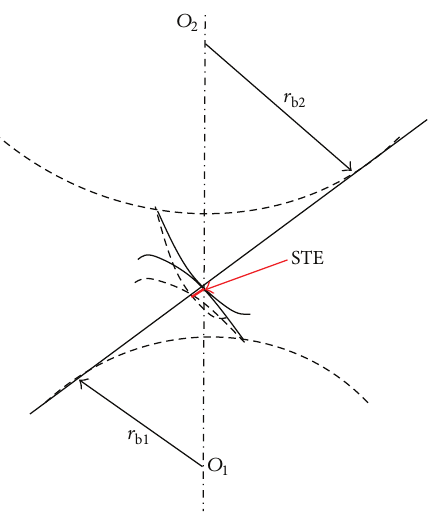
Table 2: Parameters and operating conditions.